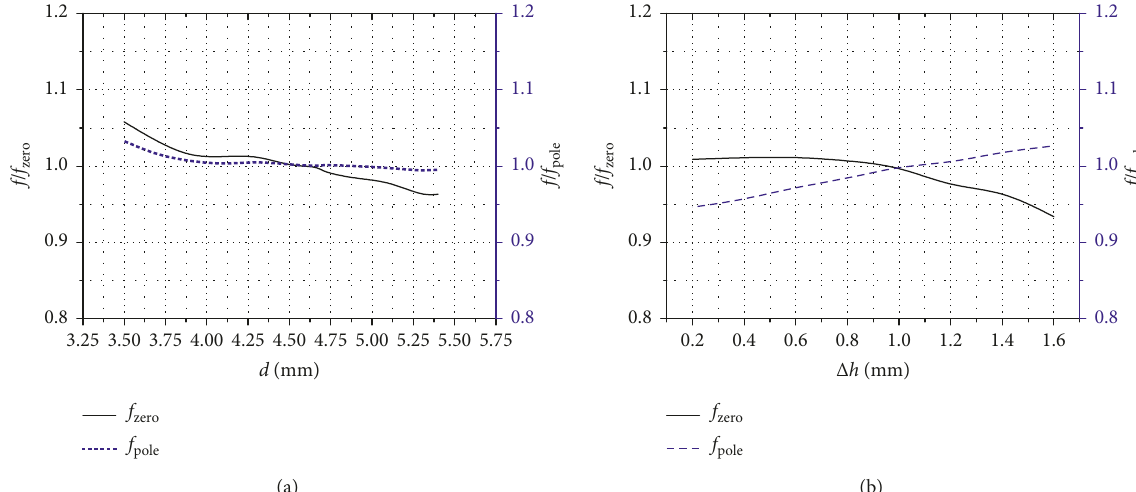
� 1mm, d � 4.67 mm, h 1